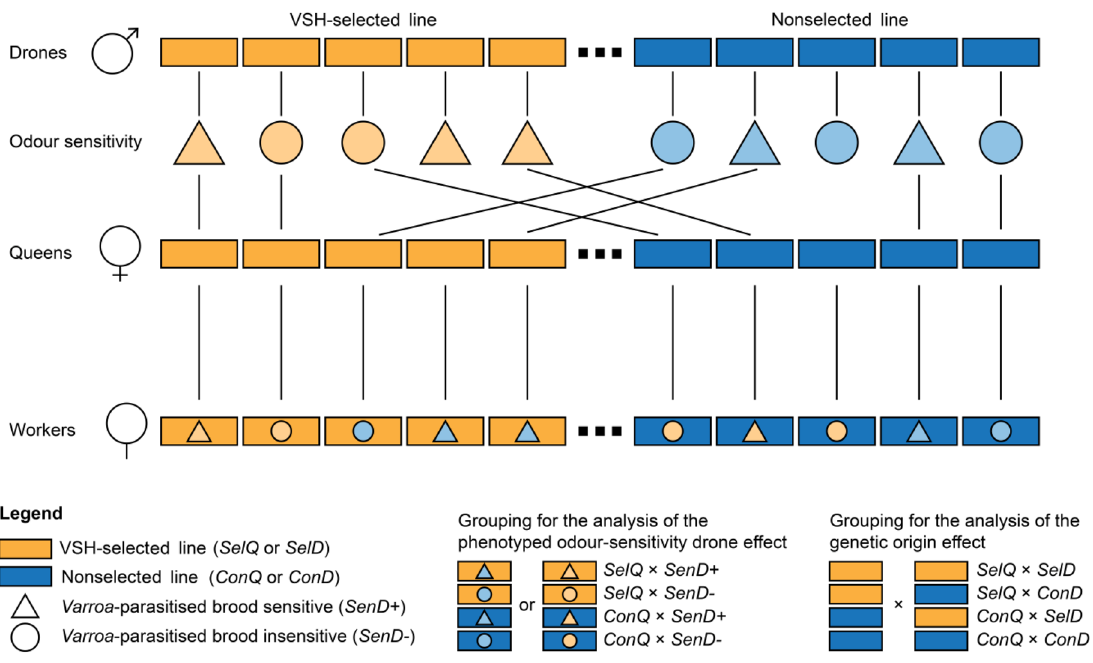
Figure 5. Mating scheme used during one-drone insemination. Drones from each of the two lines—VSH- selected line ( SelD , yellow colour) and nonselected line ( ConD, blue colour)—were tested for their odour sensitivity towards the extract of Varroa -parasitised brood. Drones, which perceived the Varroa -parasitised- brood-odour were referred to as “ Varroa -parasitised-brood-odour sensitive" ( SenD +) and marked with a triangle. Drones, that did not perceive the odour were referred to as “ Varroa -parasitised-brood-odour insensitive” ( SenD− ) and marked with a circle. The tested drones were subsequently used for the insemination of queens from both VSH-selected ( SelQ , yellow colour) and nonselected line ( ConQ , blue colour). The offspring workers were placed into four groups considering the queen’s genetic origin and the drone’s olfactory sensitivity towards the Varroa -parasitised-brood extract. The workers were subsequently assessed for their VSH in a video observation